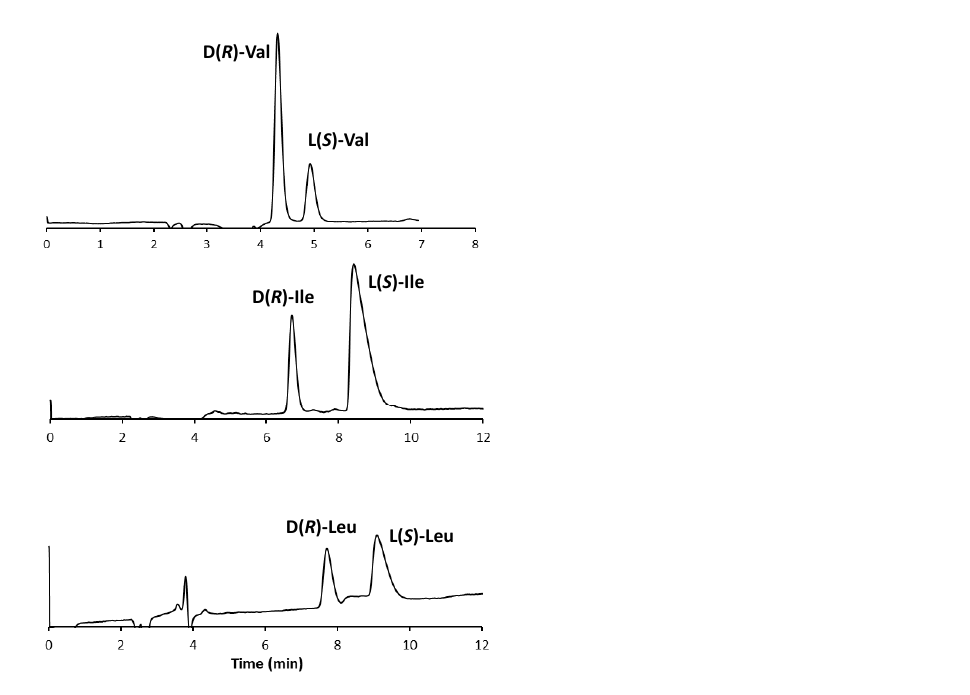
Figure 3. Chromatogram of three standard enantiomeric mixtures. Experimental conditions: column, Prevail RP18 (Grace, Sedriano , Italy) (250 mm × 4.6 mm i.d., 5 μm, 110 Å pore size); mobile phase, fully aqueous solution with 0.5 mM ( S )-OBS and 0.25 mM Cu(NO 3 ) 2 ; column temperature, 25 °C; flow rate, 1.0 mL/min; UV @ 254 nm.